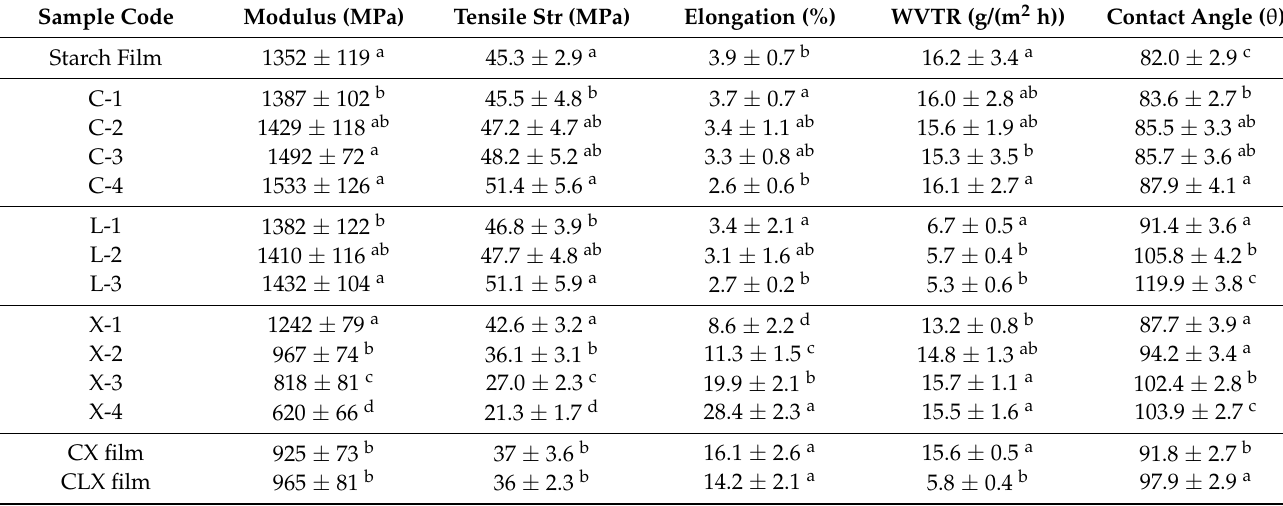
Table 2. Effect of various ingredients on the starch film mechanical performances, WVTR, and contact angle. Sample